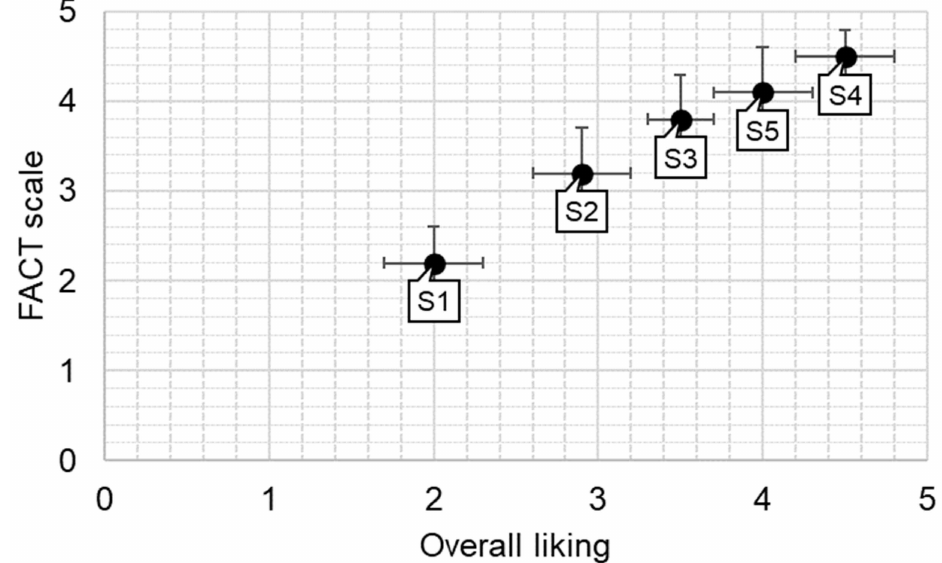
Figure 2. Evaluation of overall liking and willingness to buy (FACT scale) for tomato-based pineapple beverage samples according to Wilcoxon test applied to each variable (95% confidence). Samples S1 to S5 comprised of different concentrations of tomato juice, S1 = 80%; S2 = 70%; S3 = 60%; S4 = 50%; S5 =